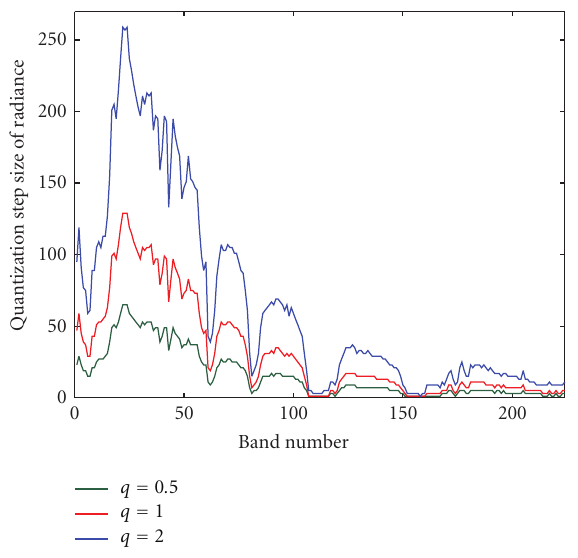
Figure 4: Quantization step sizes of radiance data.